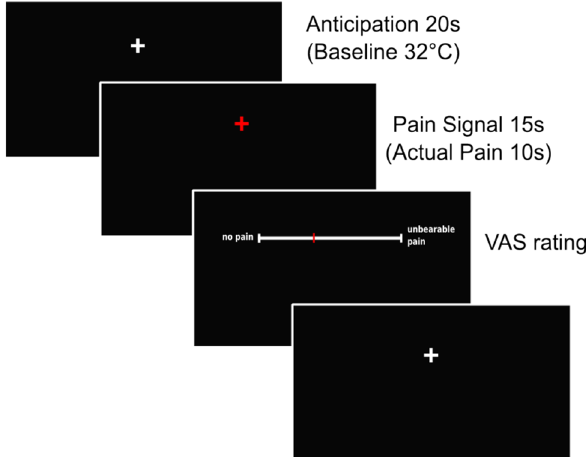
Figure 3. Pain stimulation during one experimental trial. Every experimental trial started with an anticipation phase of 20 s during which participants saw a white fixation cross. Afterwards, a red fixation cross appeared indicating the pain stimulation. The red fixation cross was shown for 15 s, while the actual pain stimulation lasted for 10 s. The pain stimulation was followed by the VAS pain rating.